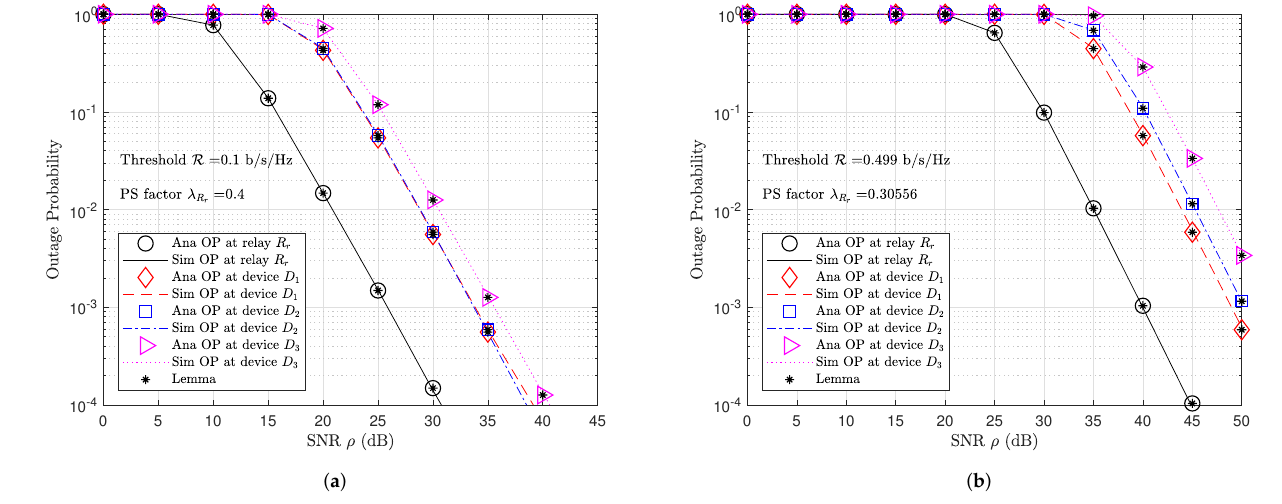
= 0.4 and fixed r